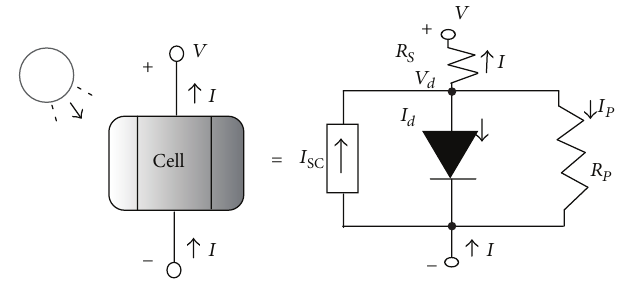
Figure 4: The equivalent circuit for a PV